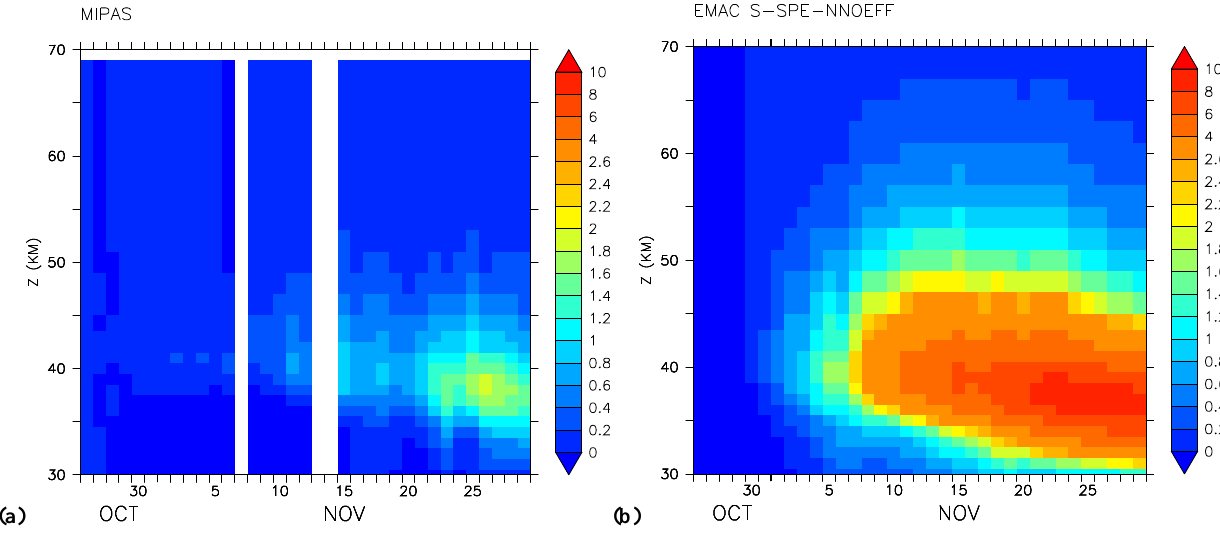
Fig. 17. N 2 O 5 changes (ppbv) for 70–90 ◦ N relative to 26 October 2003; (a) MIPAS, (b) EMAC simulation S-SPE-NNOEFF.